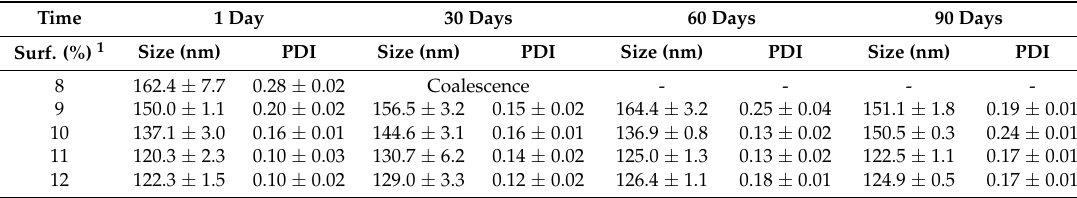
Table 2. Influence of the total concentration of surfactants on droplet size distribution and stability.